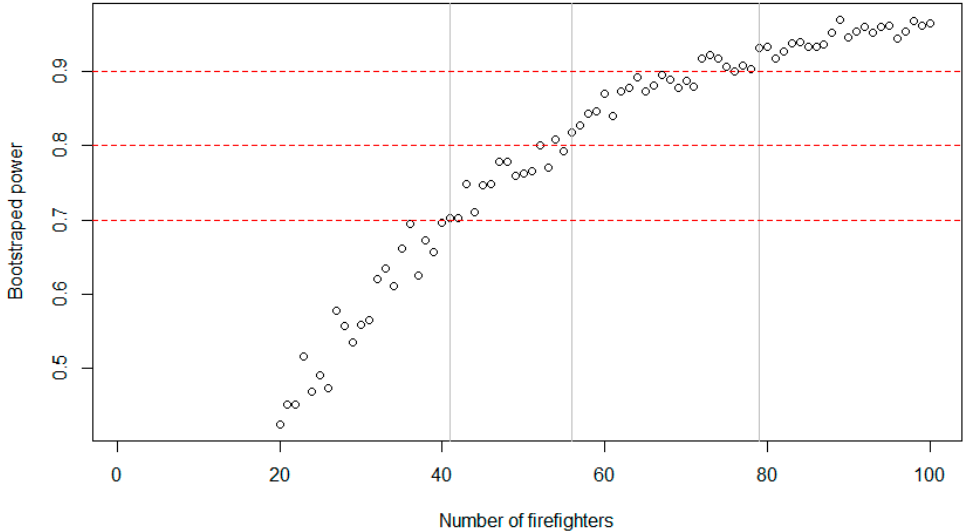
Figure 6. Illustration of bootstrap simulations (500 samples each) of the association between power ( y -axis) of the 7 out of 10 setting (20 min silent setting) and the sample size ( x -axis). Red dashed horizontal lines represent the power thresholds of 0.70, 0.80, and 0.90. The grey solid vertical lines represent the number of firefighters at least needed to reach a robust power of 0.70, 0.80, and 0.90.